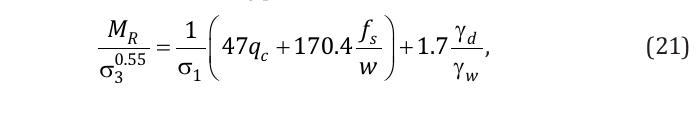
Table 2. Correlation coefficient values* Correlation coefficient